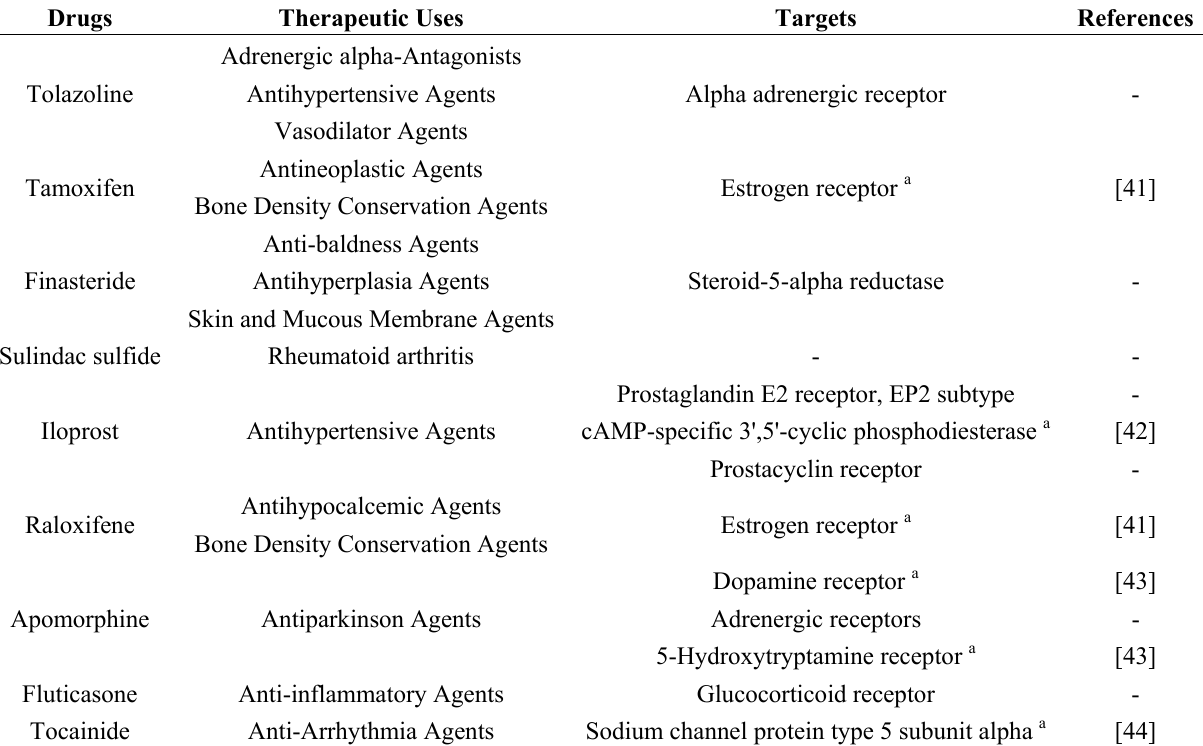
Table 2. Predicted similar drugs and associated targets of quercetin.